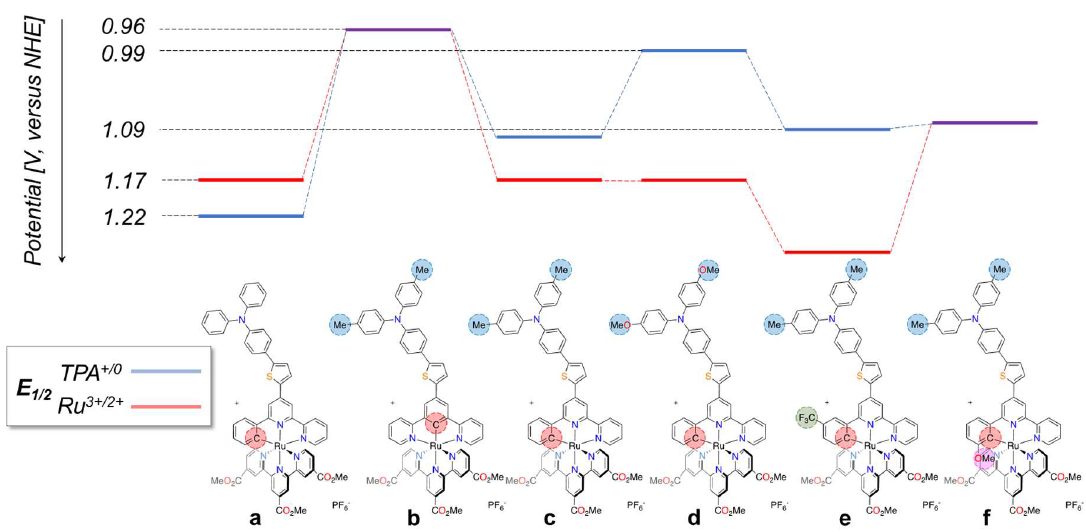
21 of 34 Figure 14. Design of bichromic sensitizers: moving from molecule a to b introduction of organic donor at the 1,3-bis(pyridine-2-yl)benzene (dpbH) cyclometalating ligand leads to destabilized filled frontier orbitals, and bathochromic shift of absorption spectrum. In case of molecule c with 6-phenyl-2,2′- bipyridine (pbpyH) cyclometalating ligand, additional D-A charge transfer band is appearing resulting in bichromic sensitizer.